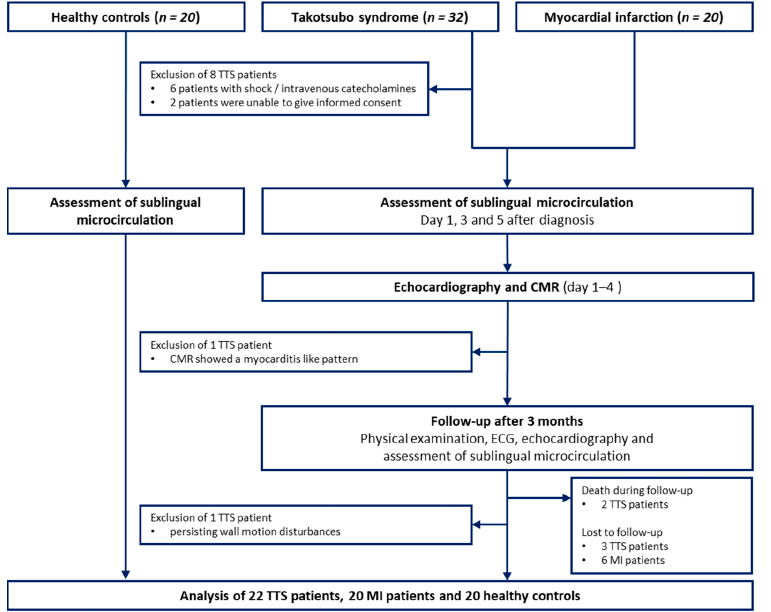
Figure 1. Study flow chart: The investigated groups consisted of prospectively enrolled patients with TTS, age- (+/ − 5 years) and gender-matched patients with MI, as well as healthy subjects (without age and gender matching). CMR = cardiovascular magnetic resonance; ECG = electrocardiography; MI = myocardial infarction; TTS = Takotsubo syndrome.